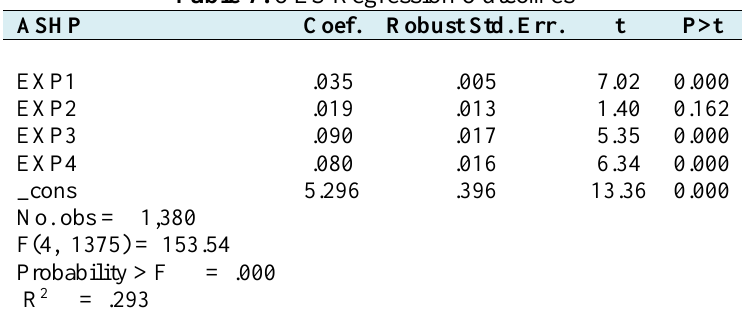
Table 7. OLS Regression